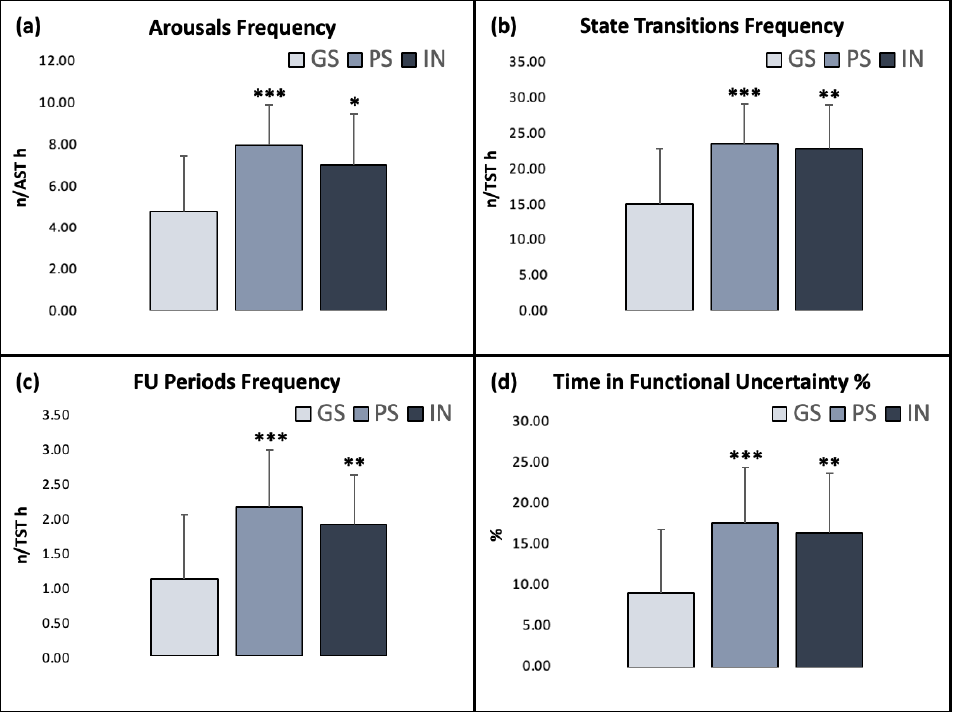
Figure 3. Sleep stability measures in the three groups. ( a ) Frequency of arousals over actual sleep time (AST); ( b ) frequency of state transitions over total sleep time (TST); ( c ) frequency of functional uncertainty (FU) periods over TST; ( d ) time in functional uncertainty (TFU) %. Asterisks indicate significant differences relative to the GS group (*: p ≤ 0.05; **: p ≤ 0.01; ***: p ≤ 0.001). Error bars represent standard deviation.